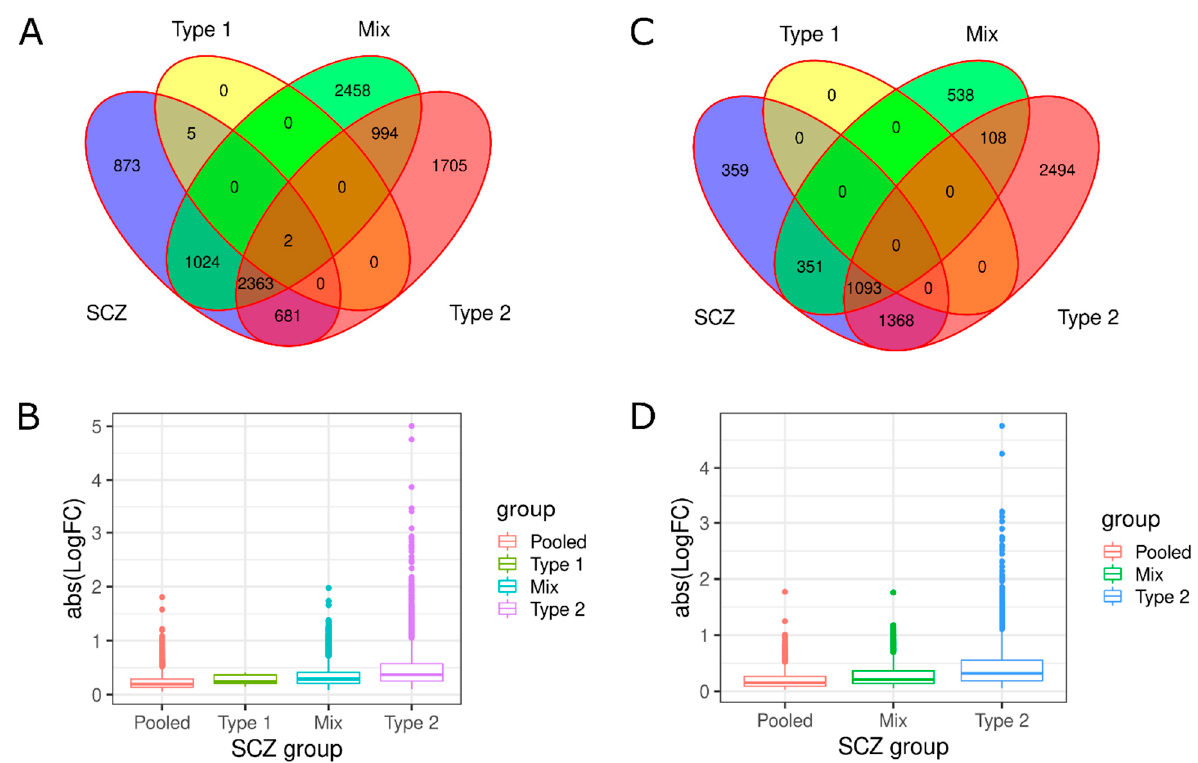
Figure 3. Type 2 schizophrenics have large differences in expression compared to schizophrenics (SCZ) pooled, Type 1, and Mix in both datasets. ( A , C ) Venn diagram of overlapping genes across the SCZ groups. Number of genes that are shared between groups will be listed in intersecting circles. SCZ pooled (blue), Type 1 (yellow), Mix (green) and Type 2 (red). ( B , D ) Boxplot of absolute log fold change (LogFC) values for each SCZ group in polyA and riboZ, respectively. The absolute value of LogFC was calculated.